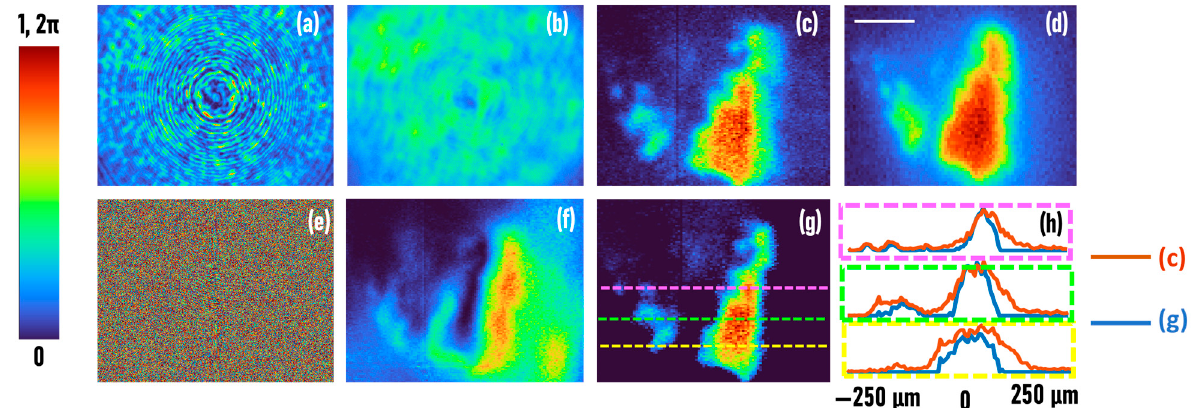
Figure 6. Experimentally recorded ( a ) PSH and ( b ) object hologram. ( c ) Reconstruction results by non-linear filter, ( d ) direct imaging. ( e ) Phase of the Fourier transform of synthetic PSH obtained from the iterative algorithm, ( f ) edge and ( g ) contrast-enhanced images. ( h ) Comparison between different line data of ( c , g ). The scale bar in ( d ) is 150 μ m.